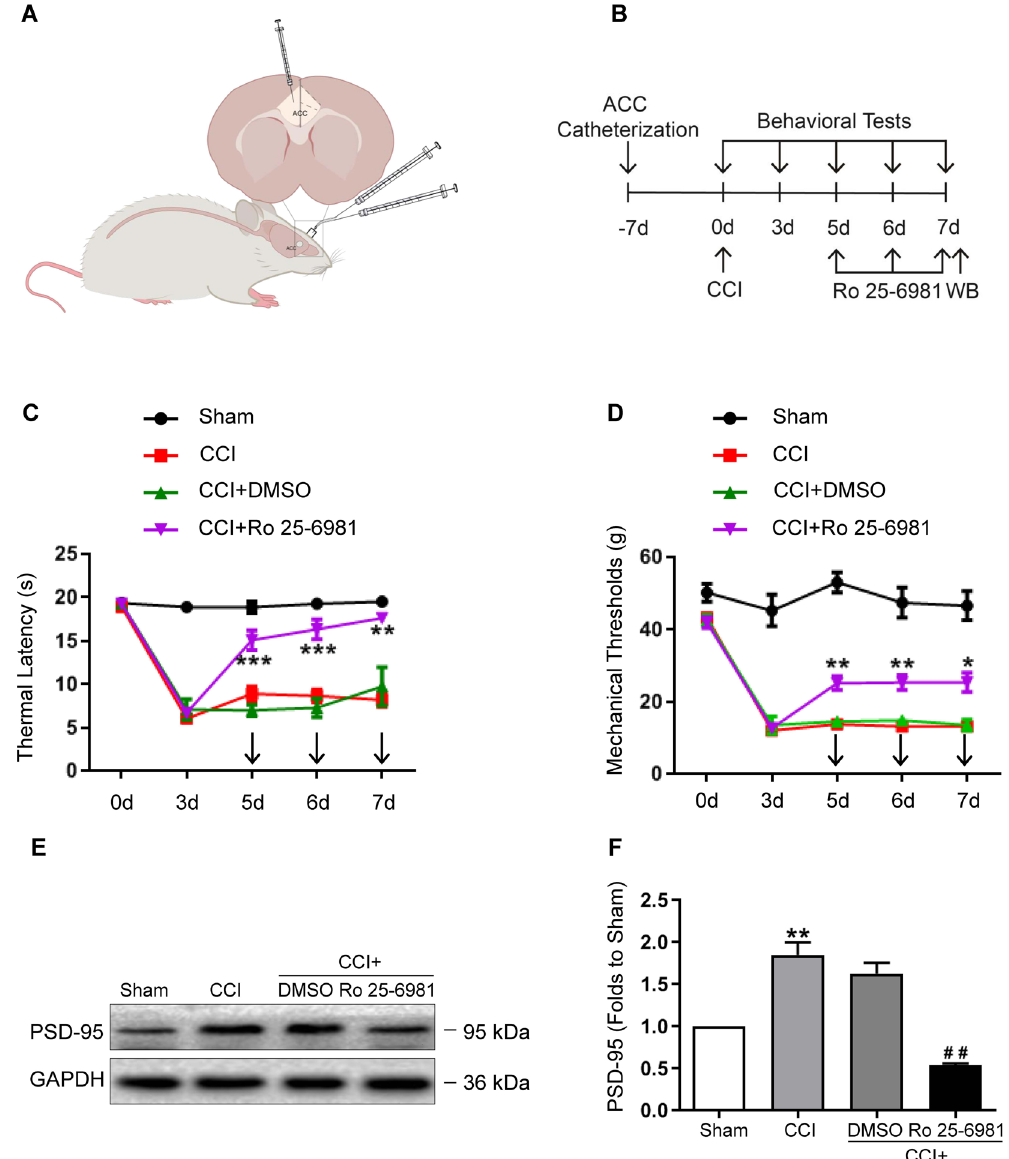
## P < 0.01, vs. CCI + DMSO, one-way ANOVA, n = 3). GAPDH was loading control and error bars